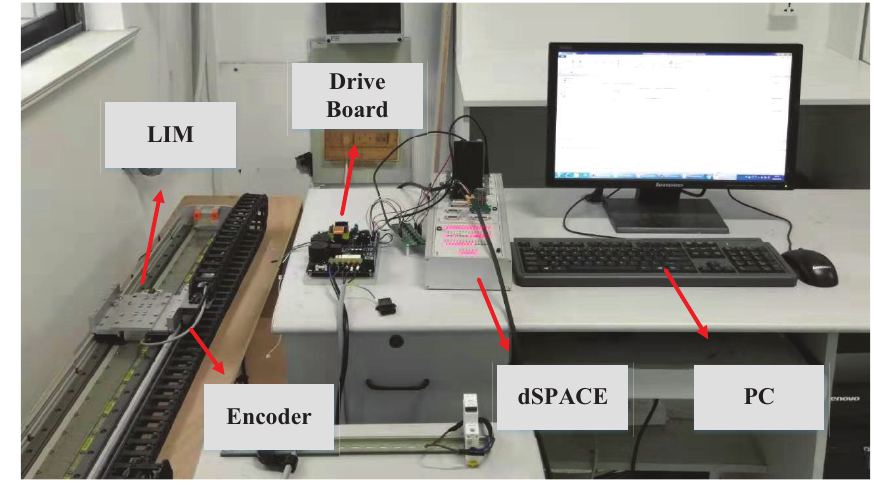
Figure 10. Hardware experimental platform based on